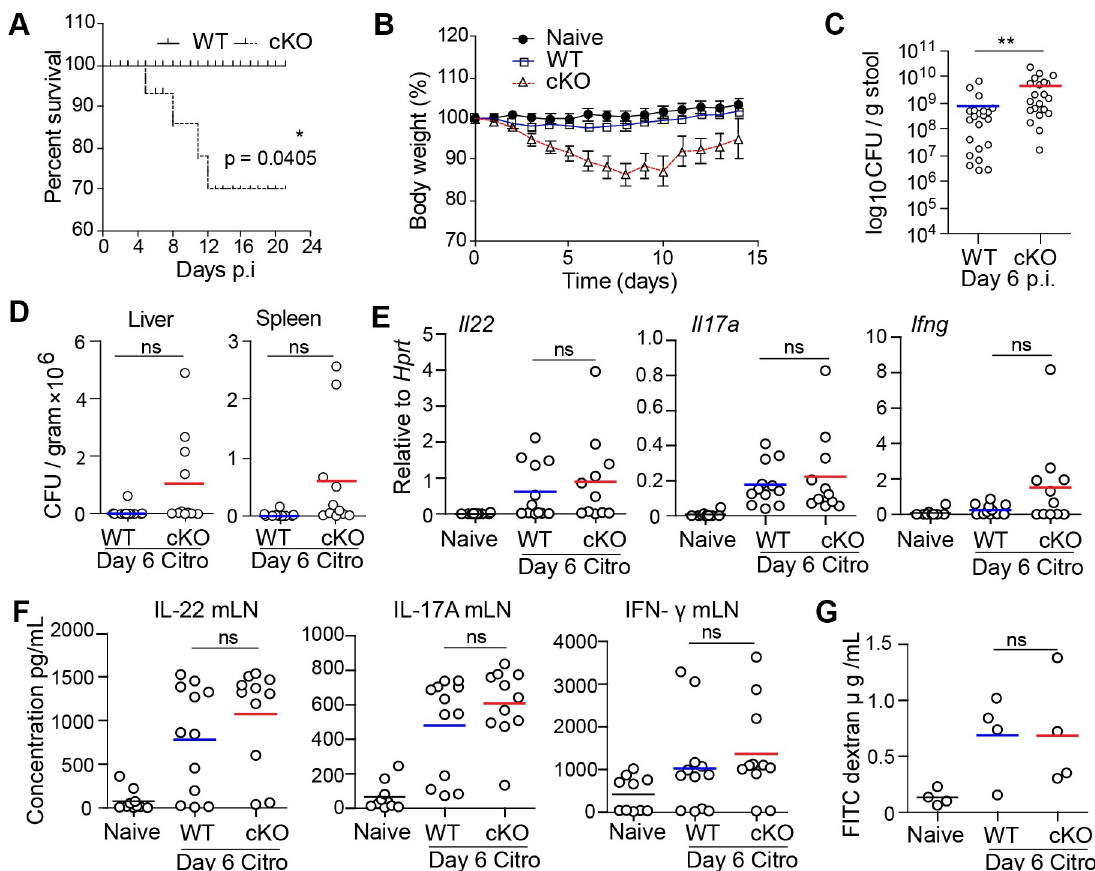
Fig 2. LSD1-deficient epithelium renders mice susceptible to C . rodentium . (A) Survival plot of WT and cKO mice after C . rodentium infection. Kaplan-Meier survival curves was used and tested with a Gehan-Breslow-Wilcoxon test to identify significant differences between wild-type and cKO mice (p value = 0.0405). (B) Body weight loss comparing Naive, WT and cKO mice during C . rodentium infection. n = 9 (naive), n = 16 (WT) and n = 14 (cKO) mice, three pooled experiments. Data points are mean and SD. (C) Stool CFU (colony forming units) counts in WT (n = 22) and cKO (n = 21) infected mice using plating on agar after 6 days of C . rodentium infection. (D) CFU counts in liver and spleen tissue of WT (n = 12) and cKO (n = 11) mice at day 6 post C . rodentium infection. (E) RT- qPCR for Il22 , Il17a and Ifng was carried out in colon tissue from naive (n = 10), WT (n = 12) and cKO (n = 11) mice infected with C . rodentium for 6 days. Expression is relative to Hprt . (F) ELISA for IL-22, IL-17A and IFN- γ in re-stimulated mesenteric lymph node cells after 6 days of C . rodentium infection. (G) Measurement of FITC dextran fluoroscence in serum derived from (naive = 4), WT (n = 4) and cKO (n = 4) infected with C . rodentium for 6 days. � P � 0.05, �� P � 0.01, Each dot represents one mouse, and means are